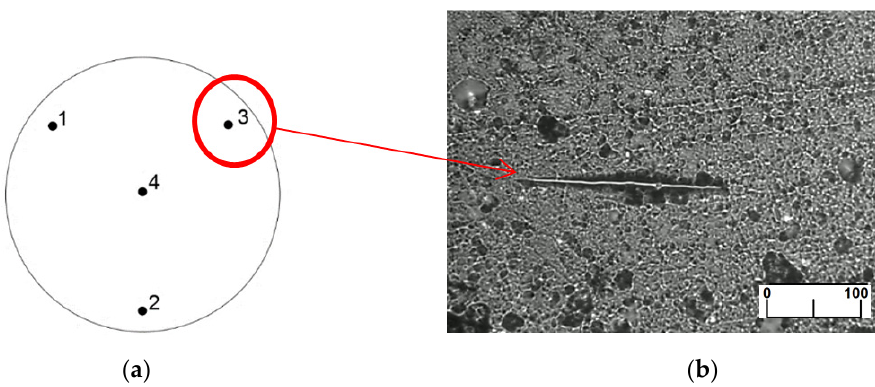
Figure 3. Microhardness measurement: ( a ) distribution of measuring points on surface of tested sample, ( b ) exemplary indentation in surface of polymeric material (PEEK/BG).